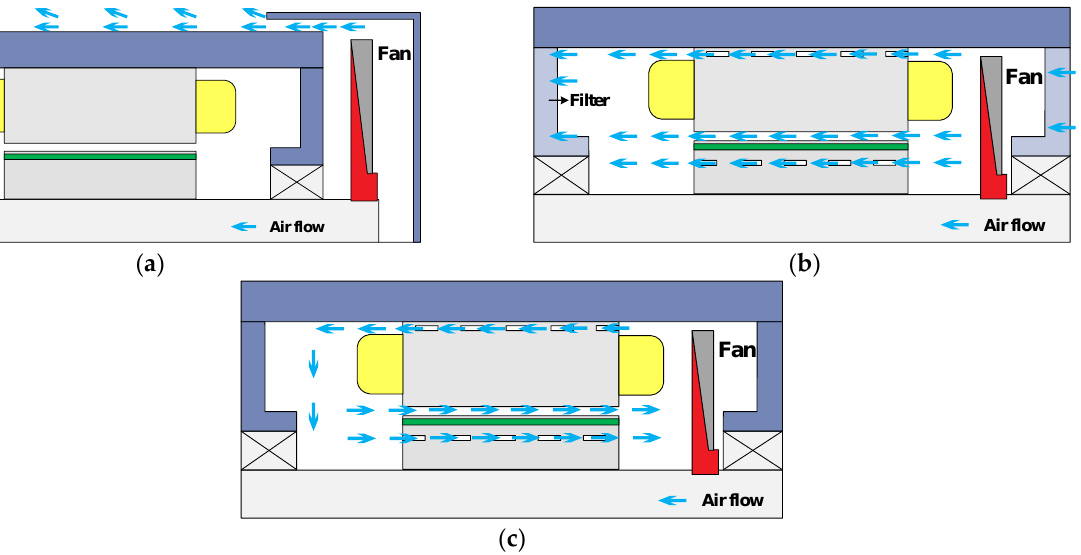
Figure 8. Air flows in ventilation system for an IPM machine. ( a ) External fan cooling. ( b ) Internal open fan cooling. ( c ) Internal enclosed fan